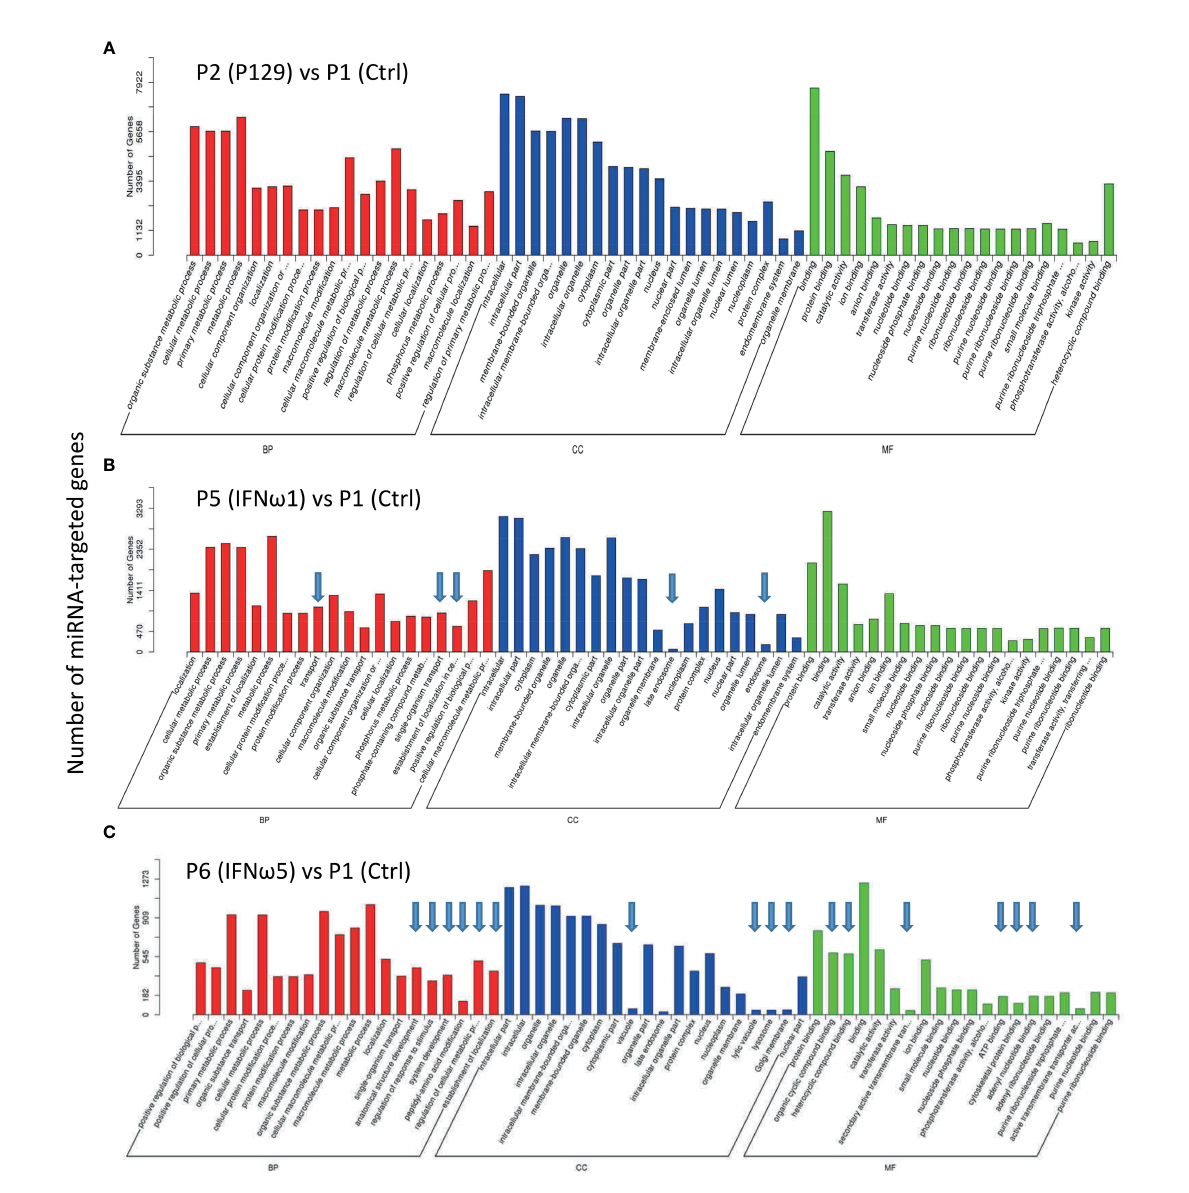
FIGURE 5 Gene Ontology (GO) analysis to unify miRNA-targeted genes in three main branches: cellular compartment (CC), molecular function (MF) and biological process (BP). Shown are GO terms with p -adj < 0.05 of signi fi cant enrichment in selected comparison of treated samples of P2 (A) , P5 (B) , and P6 (C) with the P1 control, and other samples ’ comparison is provided in Figure 9S. Wallenius non-central hyper-geometric distribution was used to discover signi fi cantly enriched GO terms in target gene candidates relative to the reference gene background (http:// www.geneontology.org/). Arrows indicate unique top GO items detected compared with the P2 vs